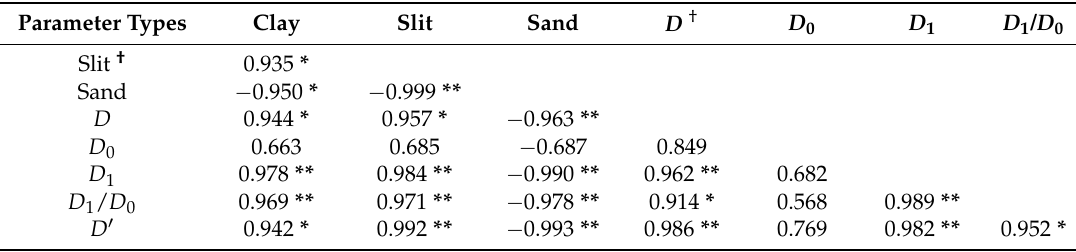
Table 4. Correlation analysis between soil fractal parameters and soil particles content and soil WRC under the different vegetation